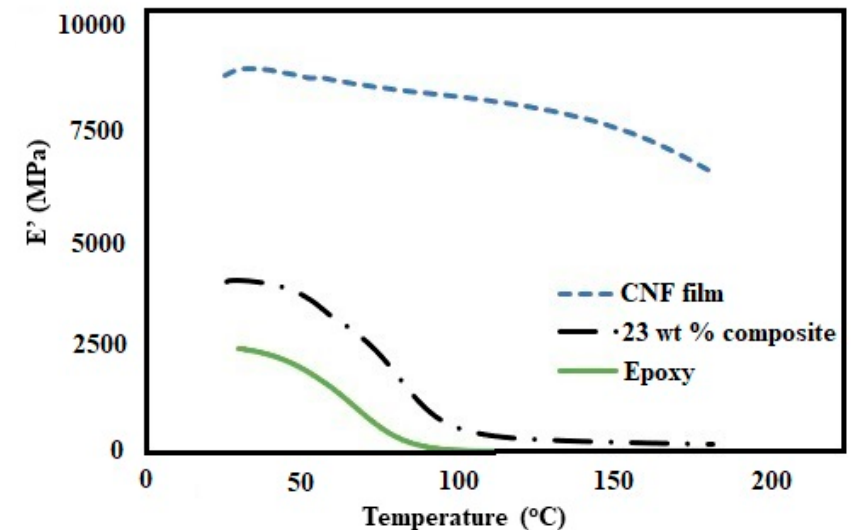
Figure 8. Temperature dependence of the storage modulus E ′ for pure CNF, epoxy, and the 23 wt % composite.